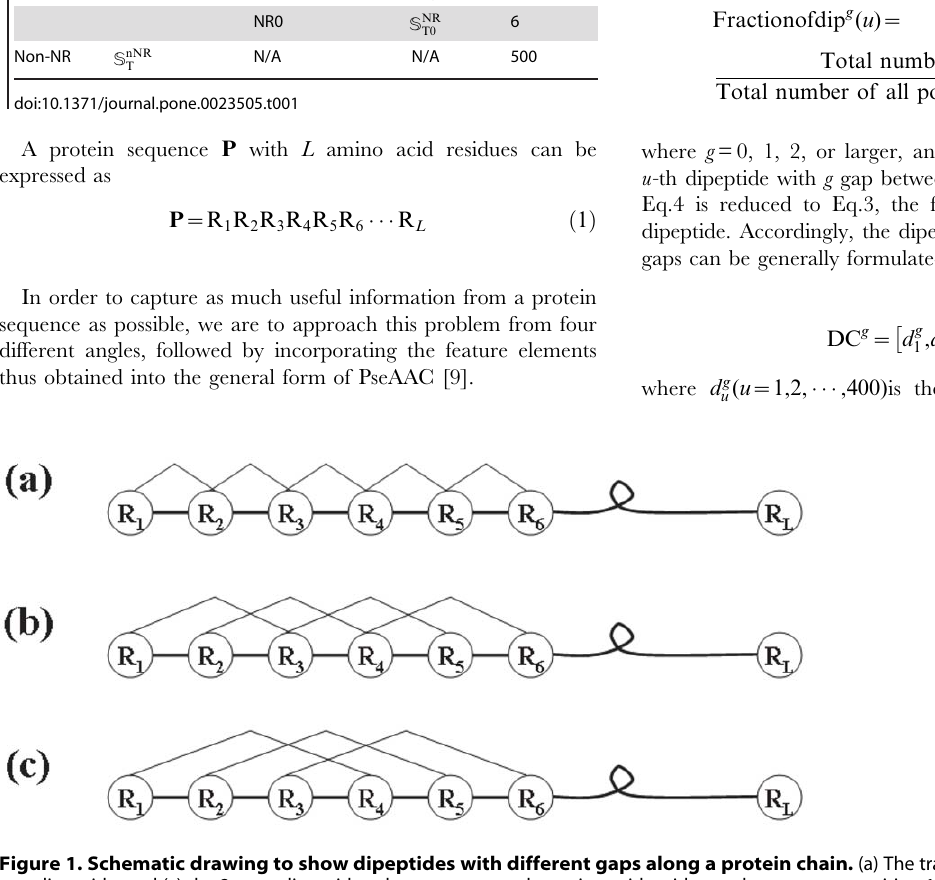
Figure 1. Schematic drawing to show dipeptides with different gaps along a protein chain. (a) The traditional (0-gap) dipeptide, (b) the 1- gap dipeptide, and (c) the 2-gaps dipeptide, where represents the amino acid residue at the sequence position 1, at position 2, and so forth. Adapted with permission from Chou [6]. doi:10.1371/journal.pone.0023505.g001 PLoS ONE |